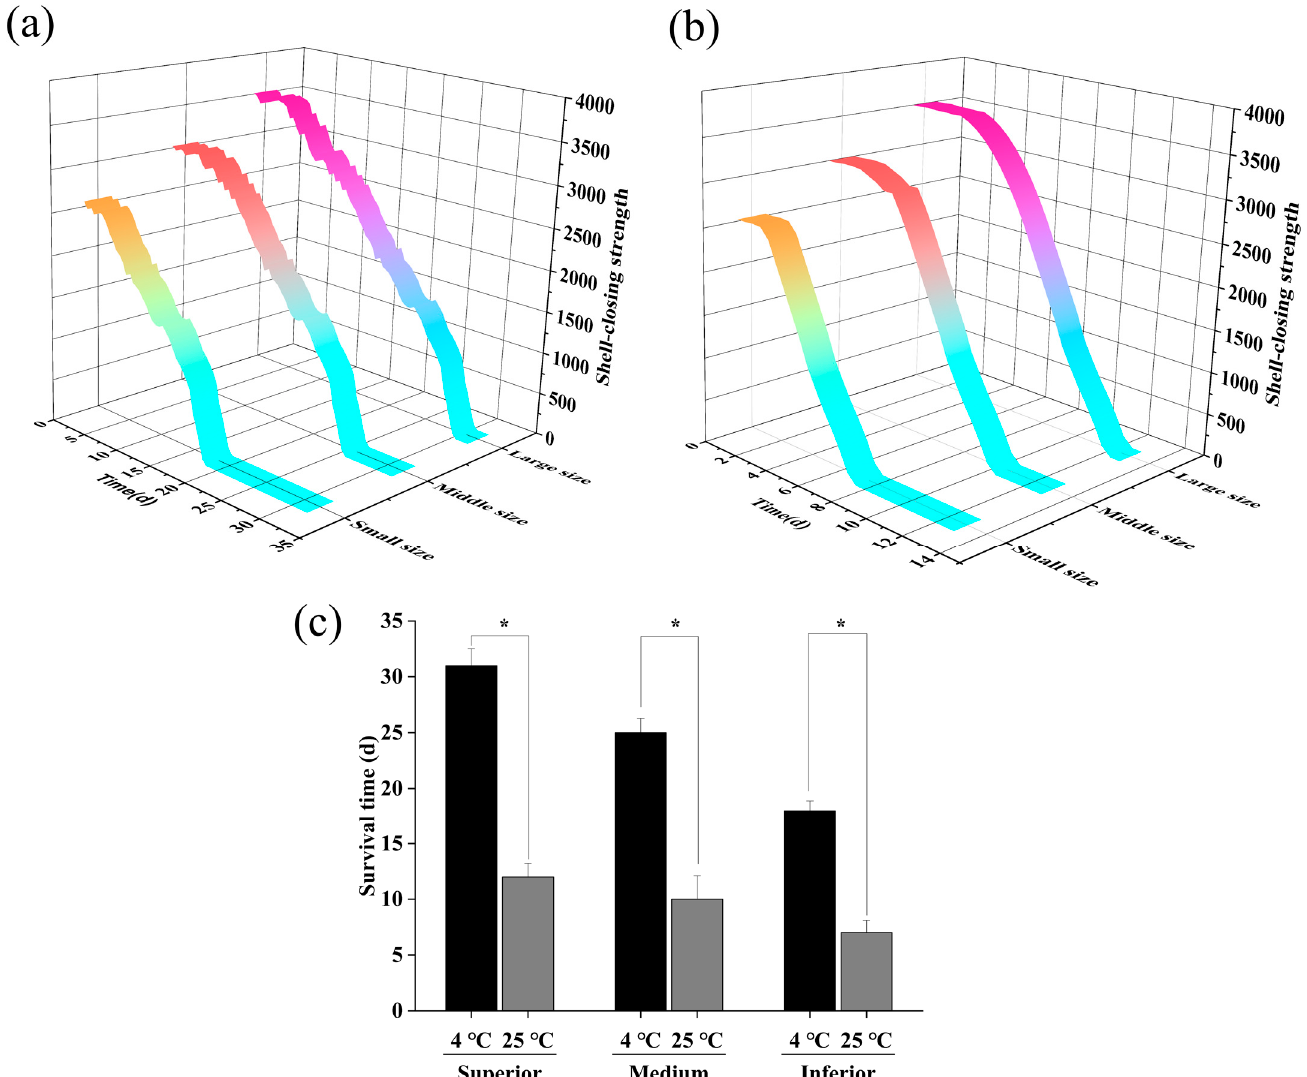
Figure 8. Oyster shell-closing strength change trend. ( a ) Live oyster SCS change characteristics under 4 °C; ( b ) live oyster SCS change characteristics under 25 °C; ( c ) comparative analysis of survival time at different temperatures. * Indicates significant difference in survival time of oysters at 4 °C and 25 °C; different letters indicate significant differences in survival time of oysters of different sizes at the same temperature.